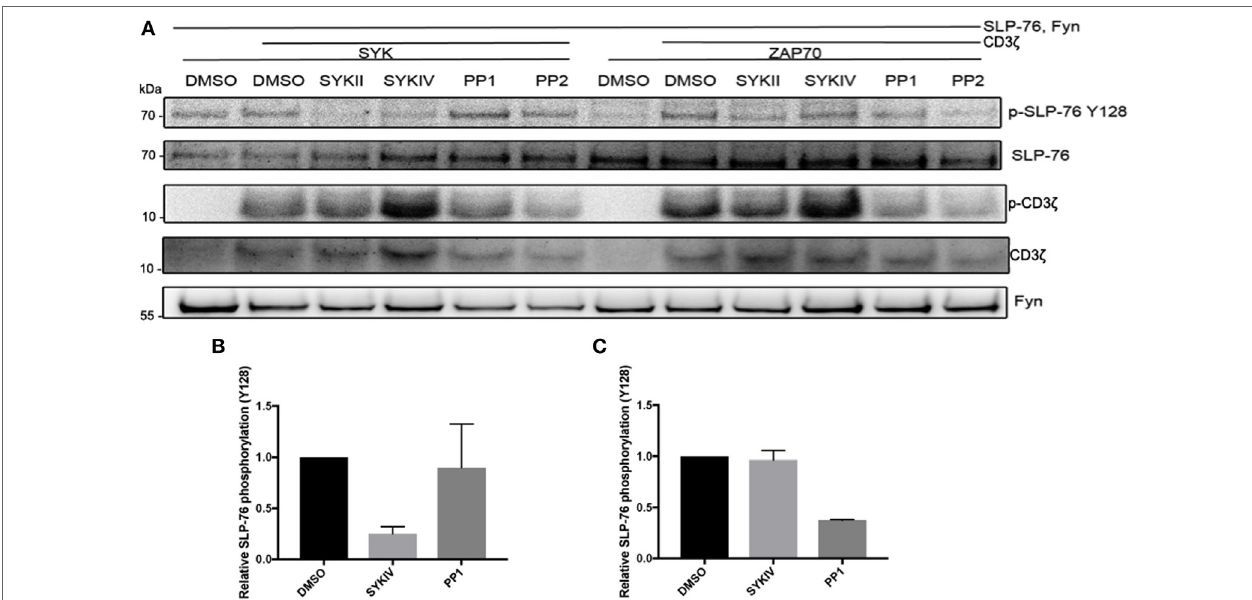
FigUre 5 | ZAP70 requires co-expression of an ITAM and Src-family kinases activity for activation. (a) S2 cells were co-transfected with the indicated proteins and pretreated with SykIV inhibitor (2.5 µM), SYKII inhibitor (2.5 µM), PP1 (10 µM), PP2 (10 µM), or DMSO solvent control 1 h before harvesting. Equal numbers of FACS-enriched GFP + cells were lysed and analyzed by western blot for SLP-76 phosphorylation and expression of transfected proteins. All western blots are representative of at least three independent experiments. (B) Quantification of SLP-76 Y128 phosphorylation relative to total SLP-76 expression upon co-expression of CD3 ζ , Fyn, SYK, and SLP-76 after pretreatment with the indicated inhibitors or DMSO control. (c) Quantification of SLP-76 Y128 phosphorylation relative to total SLP-76 expression upon co-expression of CD3 ζ , Fyn, ZAP70, and SLP-76 after pretreatment with the indicated inhibitors or DMSO